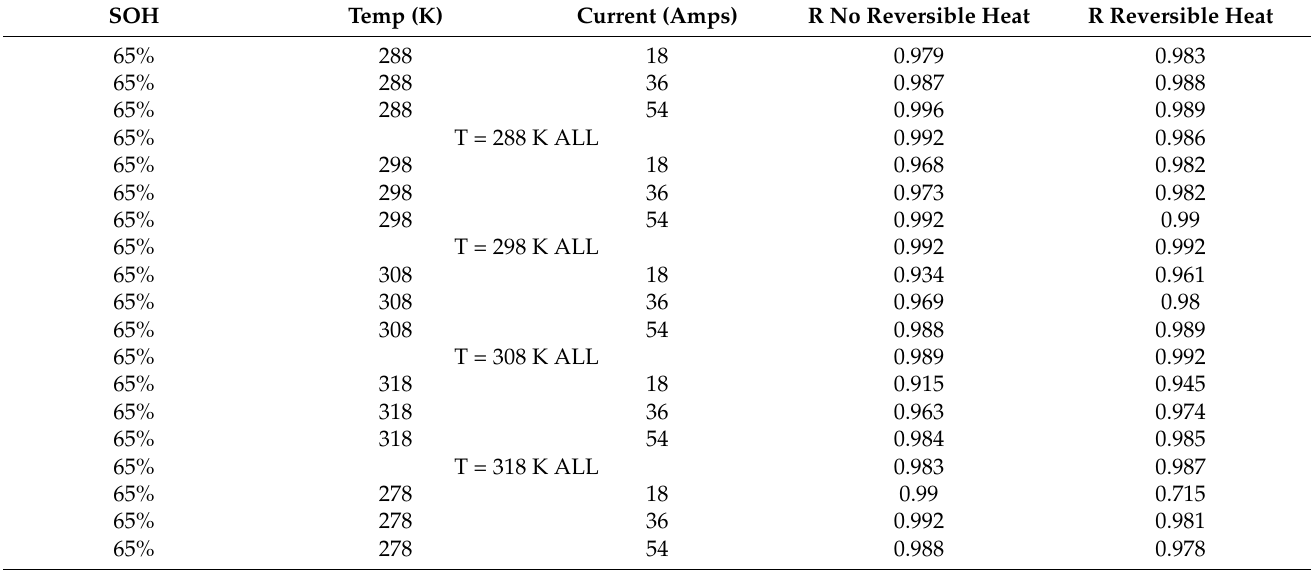
Table 6. Pearson Values for 0D thermal models with and without Reversible Heat Term. (Highest Accuracy Highlighted). T = 298 K